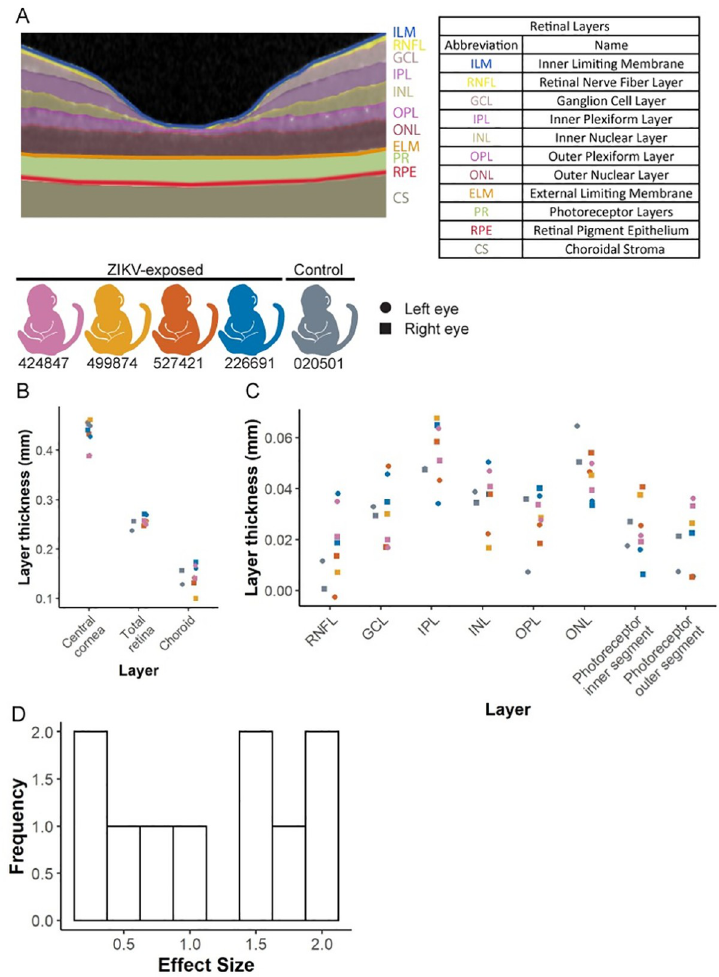
Fig 8. Ocular and retinal layer thicknesses measured by optical coherence tomography. (A) Retinal layer segmentation was performed using EXCELSIOR Preclinical, and layers are marked as an example from infant 424847. (B) Thicknesses of the retina, central cornea and choroid were measured in the ZIKV-exposed and control infants with the designated color scheme. Values from the left and right eyes are demonstrated with a circle and a square, respectively. (C) Retinal layer thicknesses were measured using the segmentation demonstrated in part A for ZIKV exposed and control infants. Both the right and left eyes were measured in all animals except for animal 499874 whose left eye was not able to be measured due to anesthesia limitations. (D) A histogram illustrates the distribution of effect sizes for all ocular layer thicknesses.